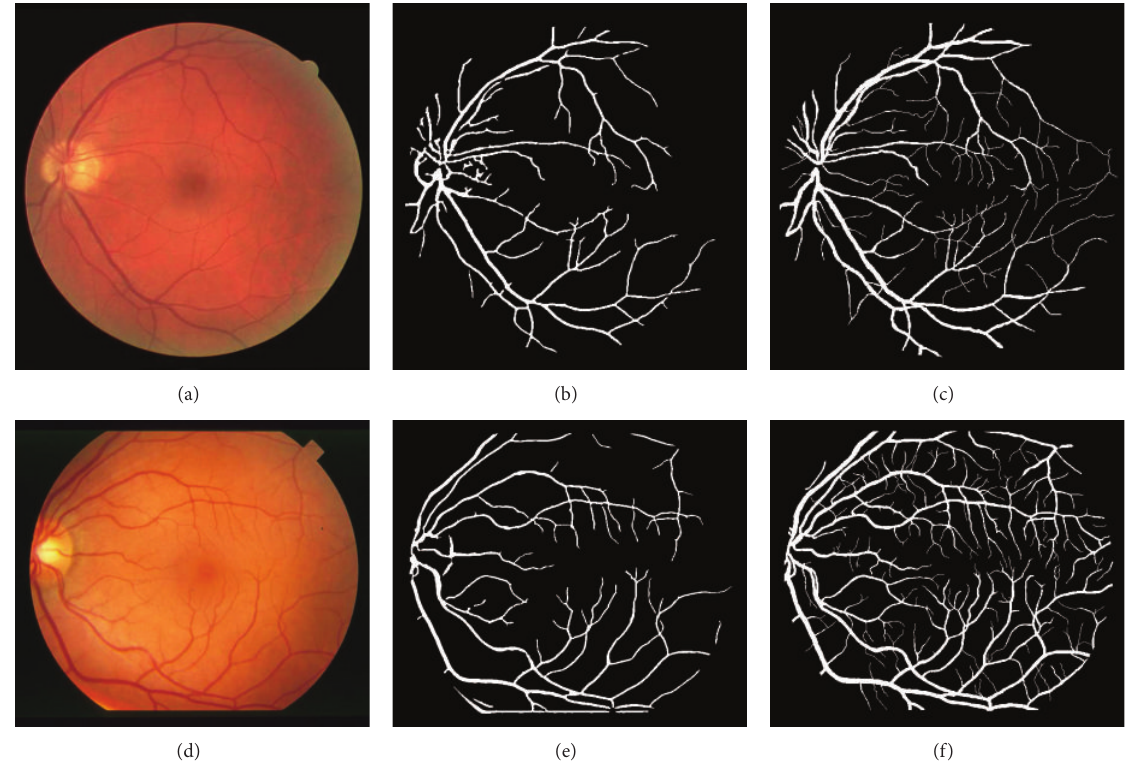
Figure 6: Example segmentation results on the DRIVE (upper row) and STARE (bottom row) public databases. From left to right: input fundus images, segmentation results, and gold standard images.